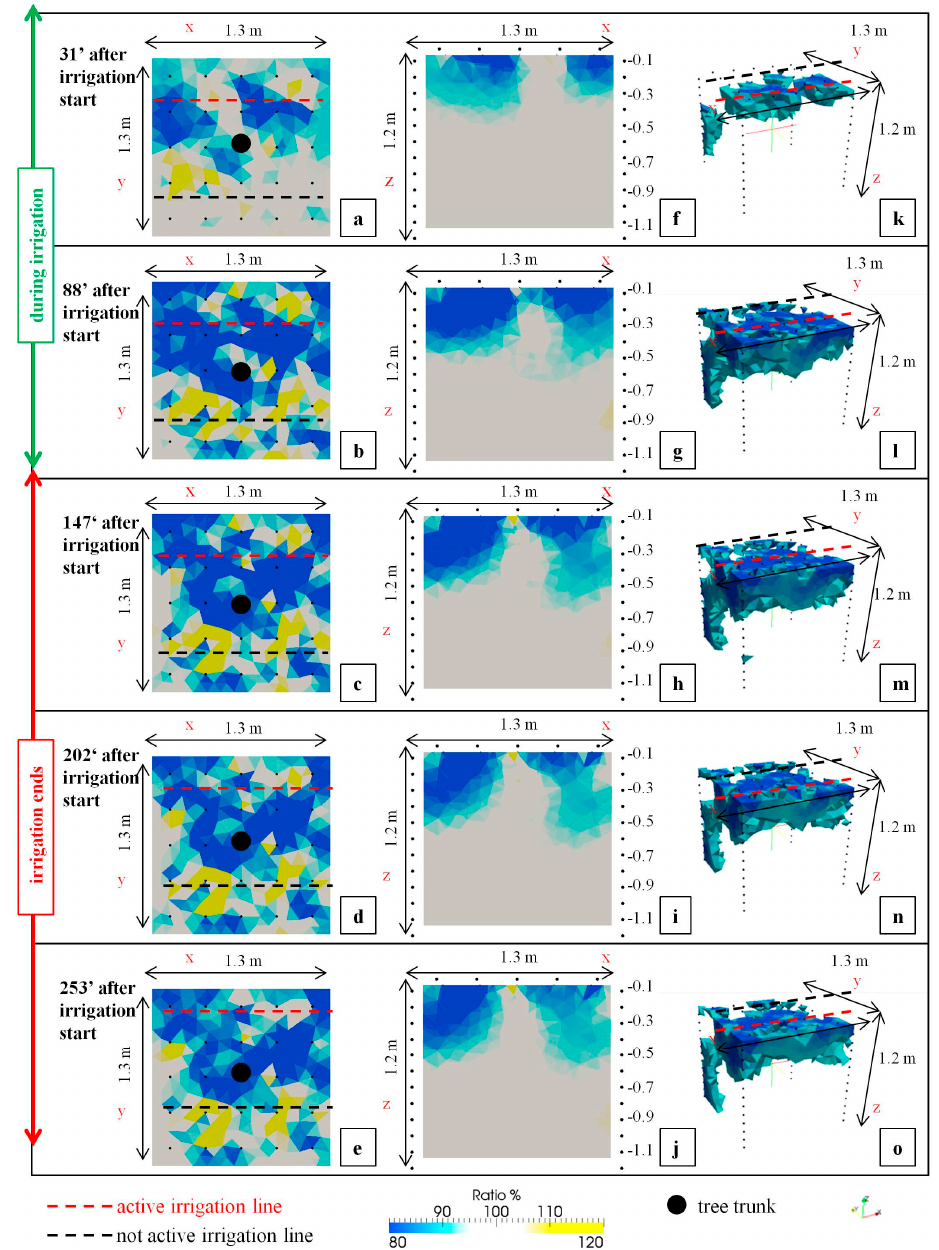
Figure 6. Time-lapse electrical resistivity (ER) ratio imagery (at the surface: a – e ; transects under the Figure 6. Time ‐ lapse electrical resistivity (ER) ratio imagery (at the surface: a ‒ e ; transects under the irrigation line: f – j ; and 3-D volumes: k – o ) for T2 with respect to the initial condition (no irrigation line: f ‒ j ; and 3 ‐ D volumes: k ‒ o ) for T2 with respect to the initial condition (no irrigation).